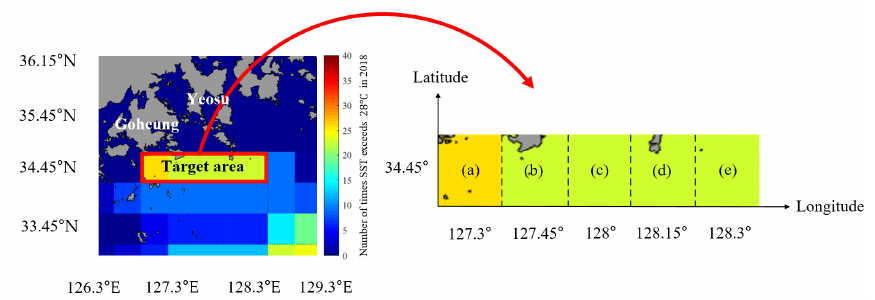
Figure 8. Individual target areas, five in total ( a – e ; latitude 34.45°, longitude 127.3°–128.3°). The color shown for each area corresponds to the frequency of HWT occurrence.